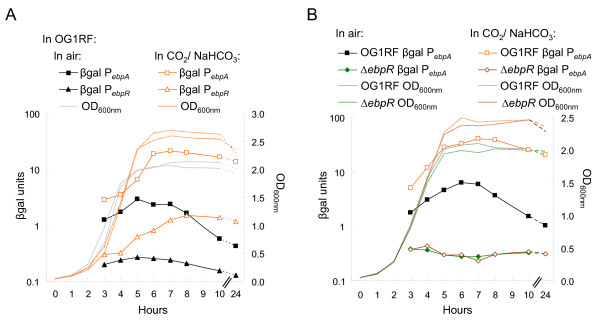
CO2/NaHCO3 induction effect on ebpA expression level. Samples were collected every hour from 3 to 8 hr, then at 10 and 24 hr after starting the culture in TSBG. The left axis represents the β-gal units (OD420 nm/protein concentration in mg/ml). The right axis indicates the OD600 nm readings. All sets of cultures presented were analyzed concurrently. Each figure is a representative of at least three experiments. A. Growth curves of OG1RF are shown in gray (in air) and in orange (in the presence of 5% CO2/0.1 M NaHCO3). OG1RF containing PebpR::lacZ (triangle) or PebpA::lacZ (square) was grown in air (closed black symbol) or in the presence of 5% CO2/0.1 M NaHCO3 (open orange symbol). B. The ΔebpR mutant containing PebpR::lacZ is represented by closed green diamond when grown in air and with open brown diamond when grown in the presence of 5% CO2/0.1 M NaHCO3.